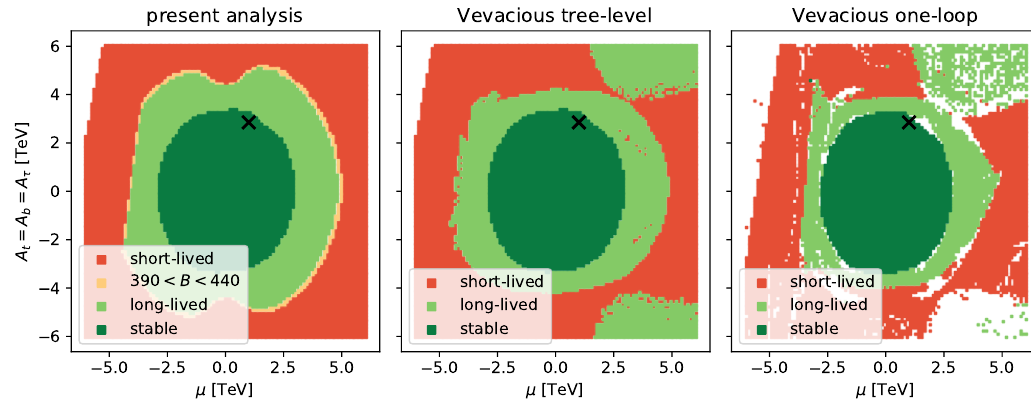
Figure 6 . Constraints from vacuum stability in the plane of (cid:22) and A containing the selected point (black (cid:2) ) from the M 125 benchmark scenario. The results from (cid:12)gure 4 are shown in the left panel. h The other two plots show results of the code Vevacious for the tree-level (centre) and one-loop e(cid:11)ective potential at zero temperature (right) for the same parameter